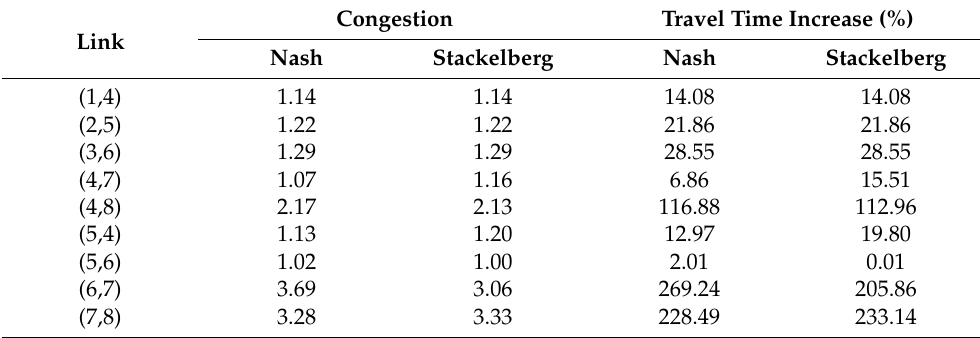
Table 11. Traffic congestion in links of transport network for scenario